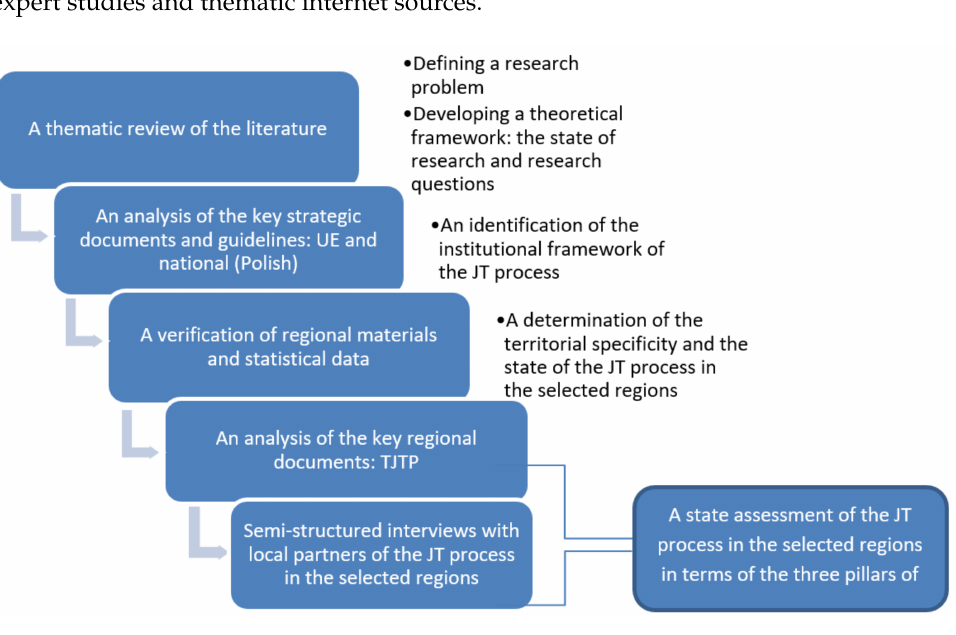
Figure 4. Stages of research. Source: own